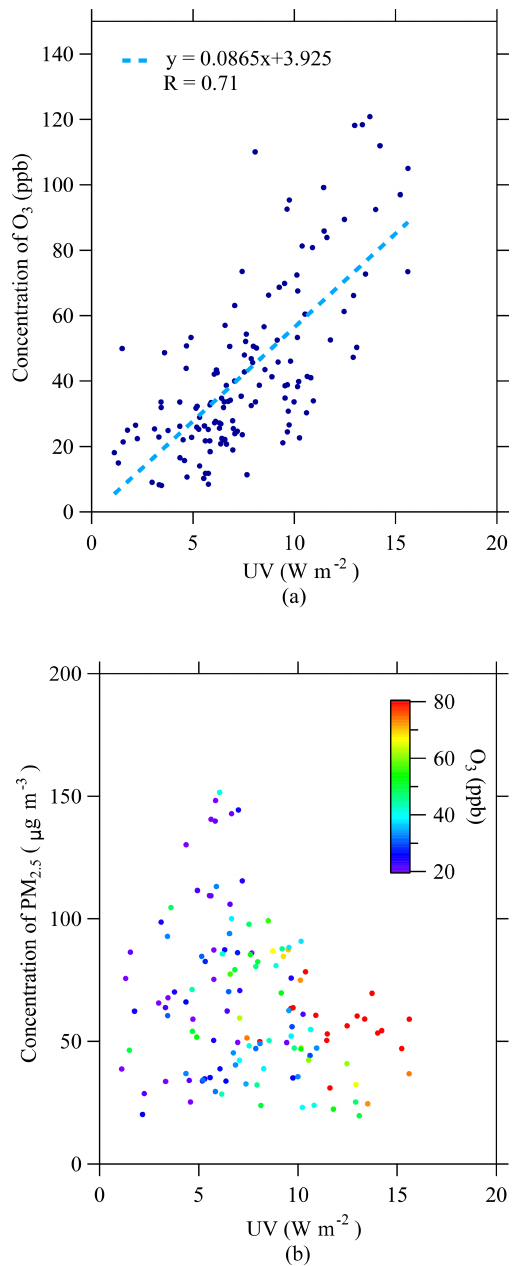
Figure 9. Scatter plots of (a) O 3 –UV and (b) PM 2 . 5 –UV color- coded with O 3